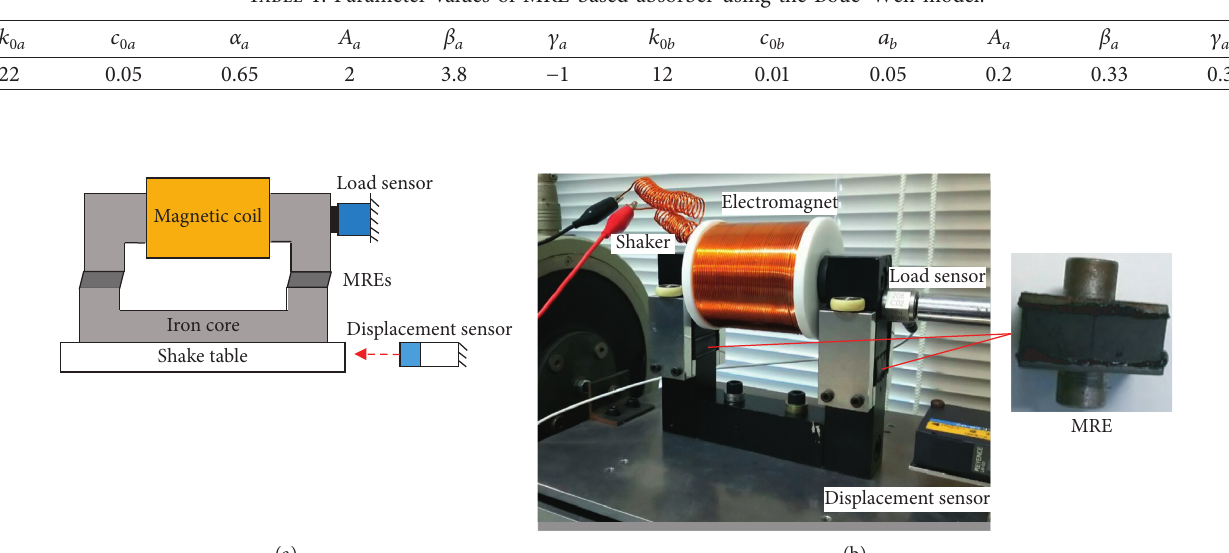
Figure 3: Experimental schematic for collecting force-displacement data under different current values: (a) schematic; (b) photo.